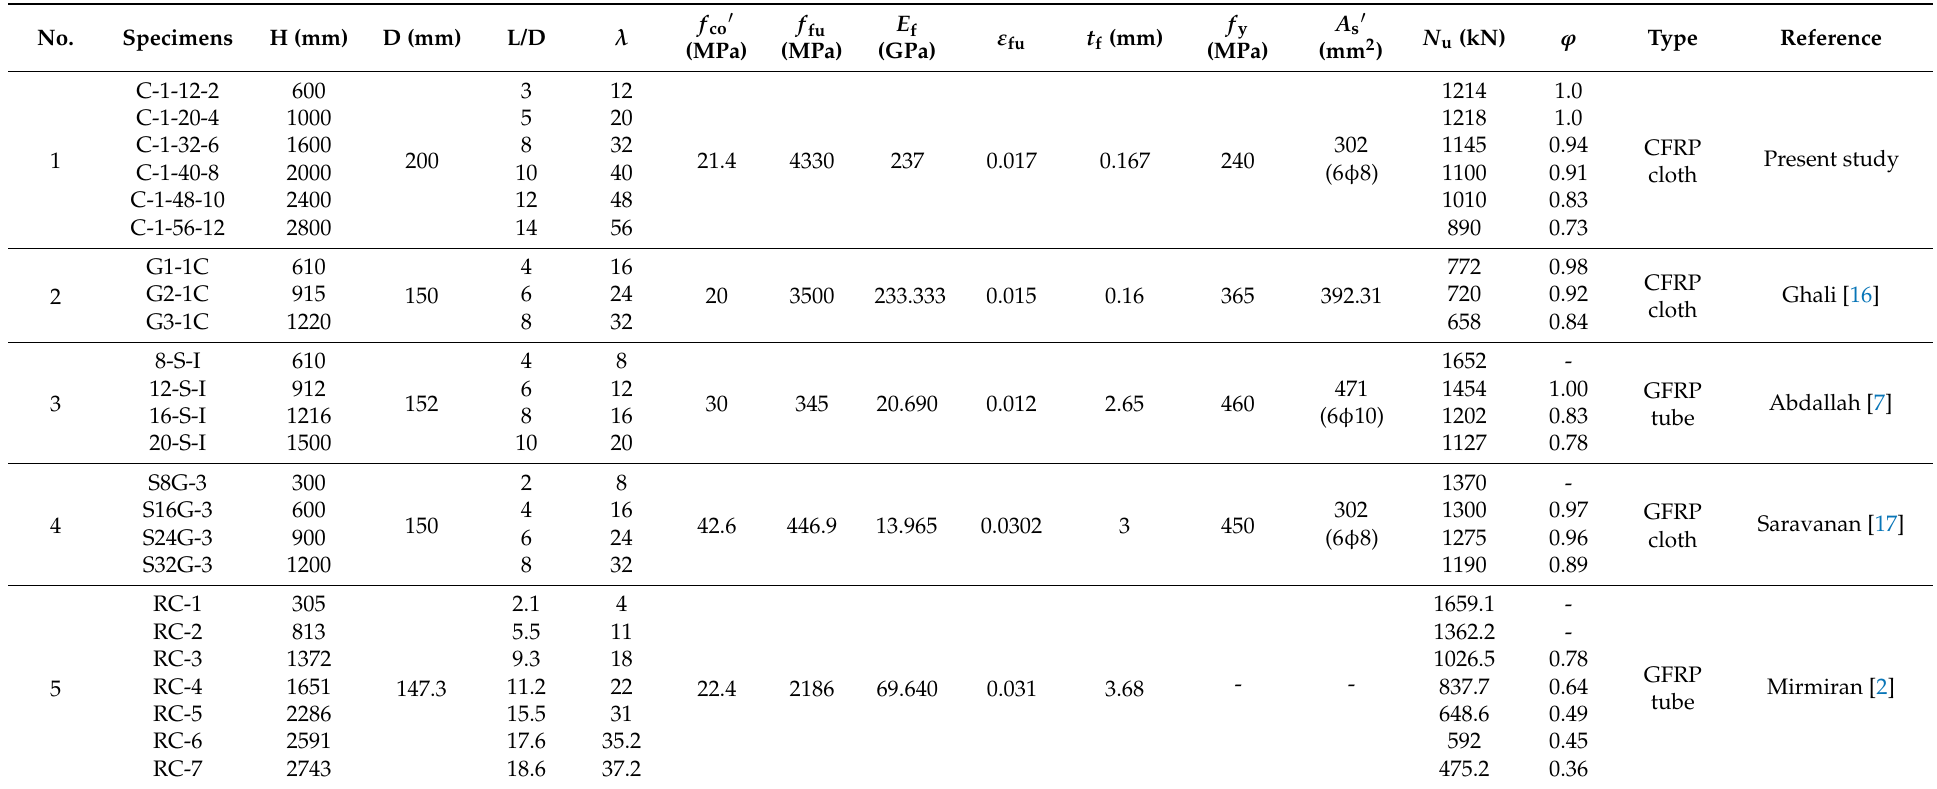
Table 4. Summary of test results of FRP-confined circular RC